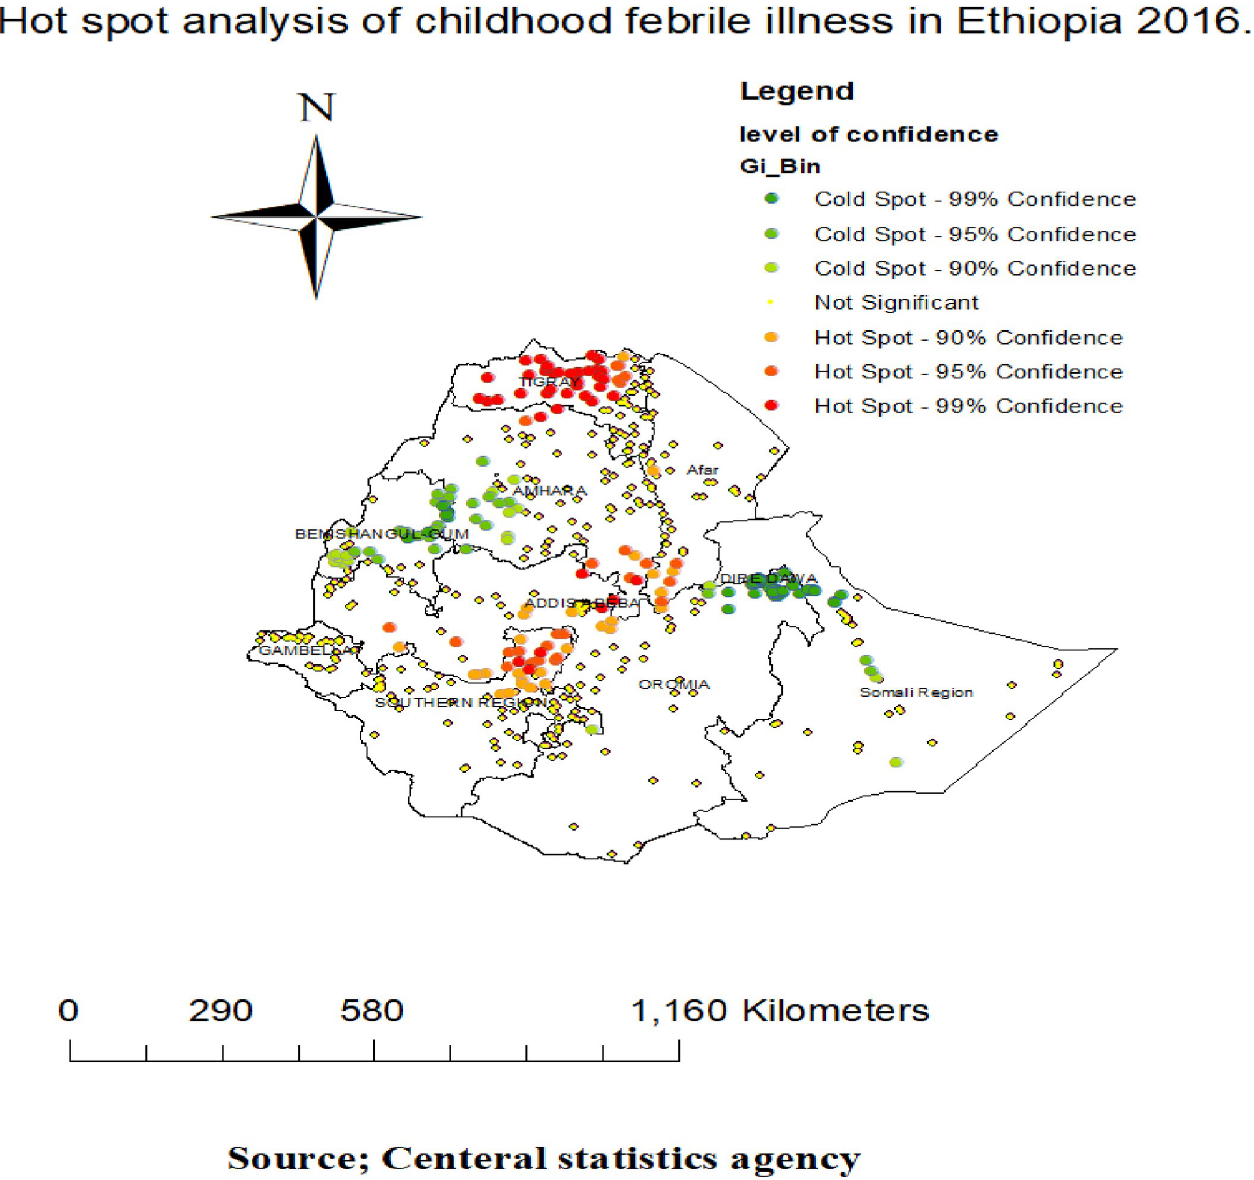
Fig 4. The Getis Ord Gi statistical analysis of hot spots of febrile illness among under-five children in Ethiopia, 2016.